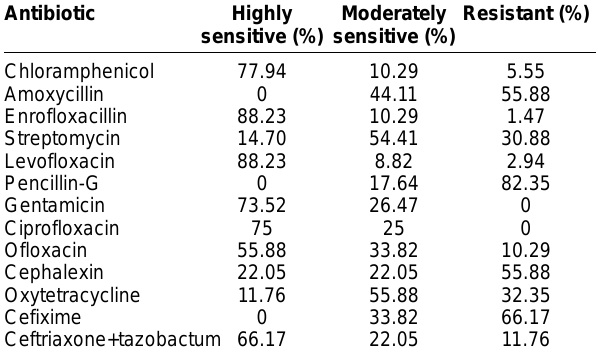
Table-2. Overall antimicrobial succeptibility profile Antibiotic